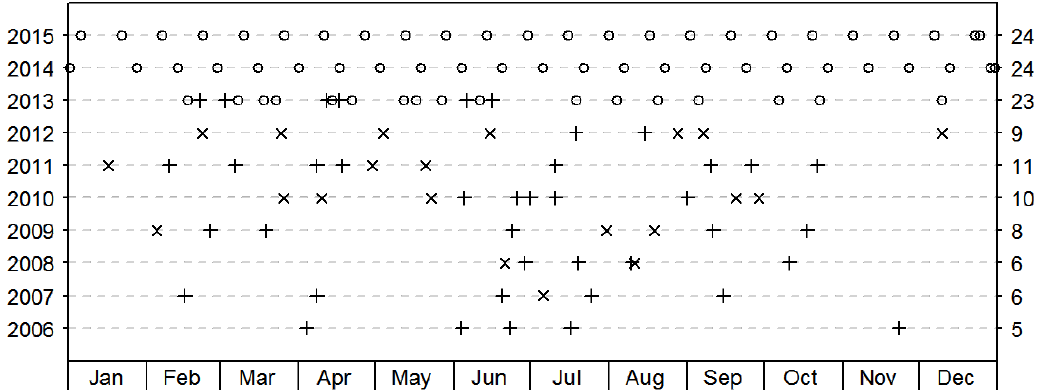
Figure 2. Timeline of the optical satellite acquisitions performed by Spot-2/4/5 or Landsat-8 during the 2006–2015 period. The total number of images acquired per year is indicated on the right, and different symbols to represent resolutions of 10 m (×), 20 m (+) and 30 m (o).